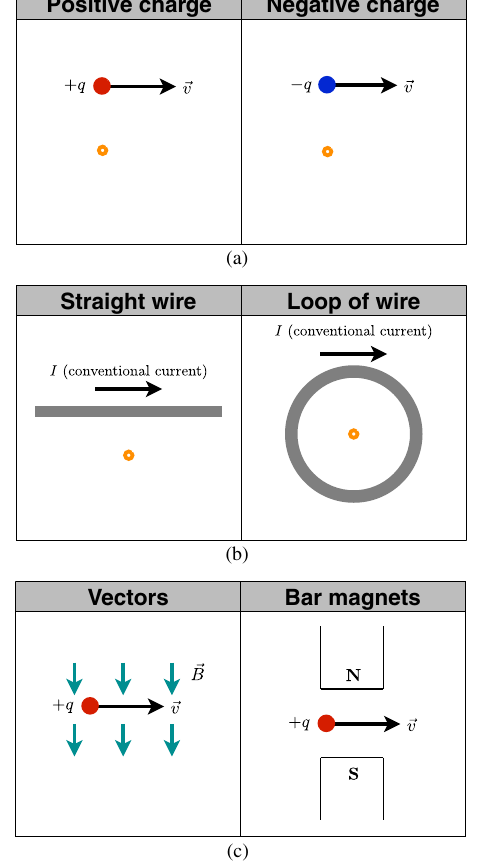
FIG. 7. Examples of the variation in physics features. The ‘ Sign ’ of the charge, which was varied between the positive and negative charges in (a) and the current-carrying wires in (b). The ‘ Shape ’ of the current-carrying wire in (b) was also varied between straight and circular. Finally, the representation of magnetic ‘ Field ’ was varied between a vector or arrow repre- sentation and a bar magnet representation, shown in